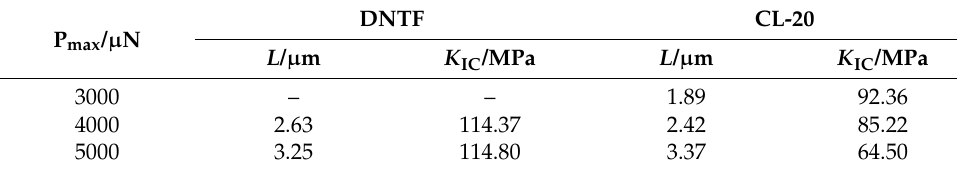
Figure 10. Crystal indentation crack at 3000 μ N for ( a ) DNTF and ( b ) CL-20. Table 2. Crack length and fracture toughness values at different loads.